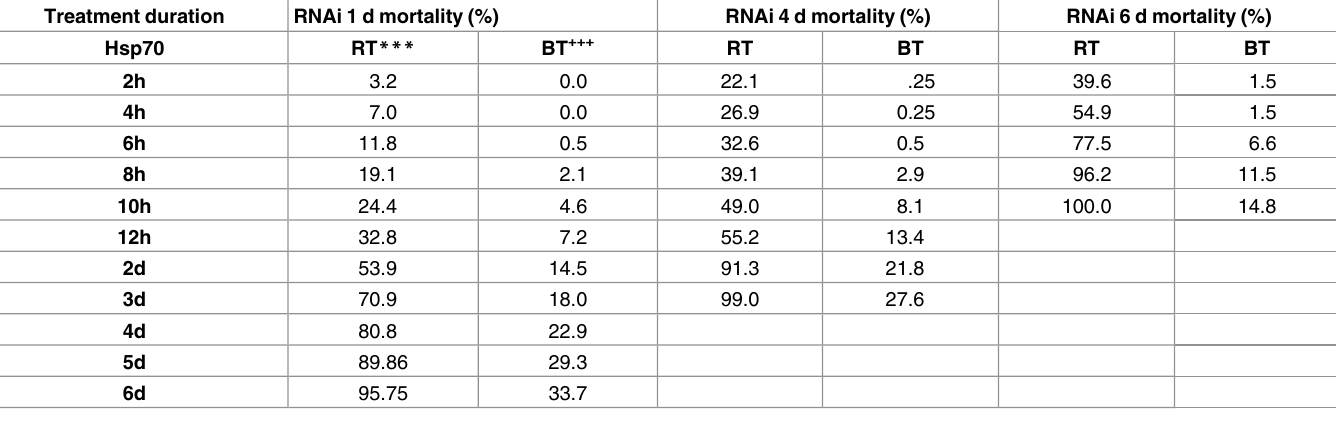
*** RNAi and heat-stress treatment